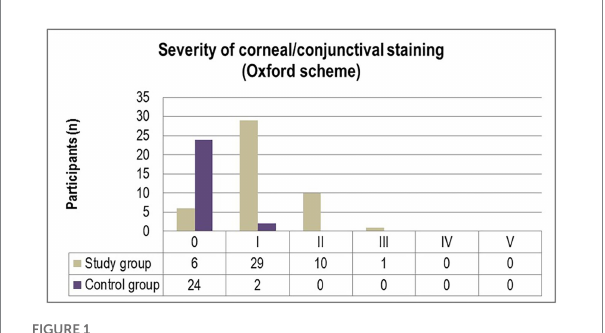
FIGURE 1 Distribution of severity grades of corneal/conjunctival staining (Oxford scheme) in the study and control groups.